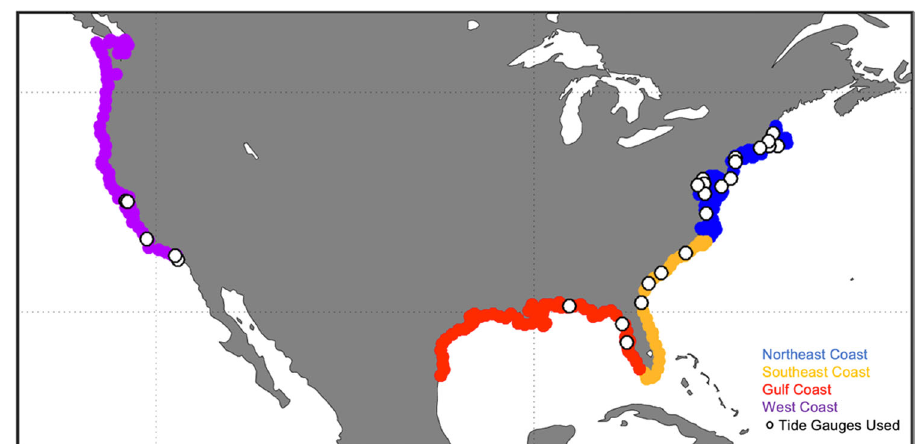
Fig. 2 United States coastal regions. De fi nition of the coastal regions used in this study: Northeast (blue), Southeast (orange), Gulf (red), West (purple). Tide gauges used are shown as white markers.